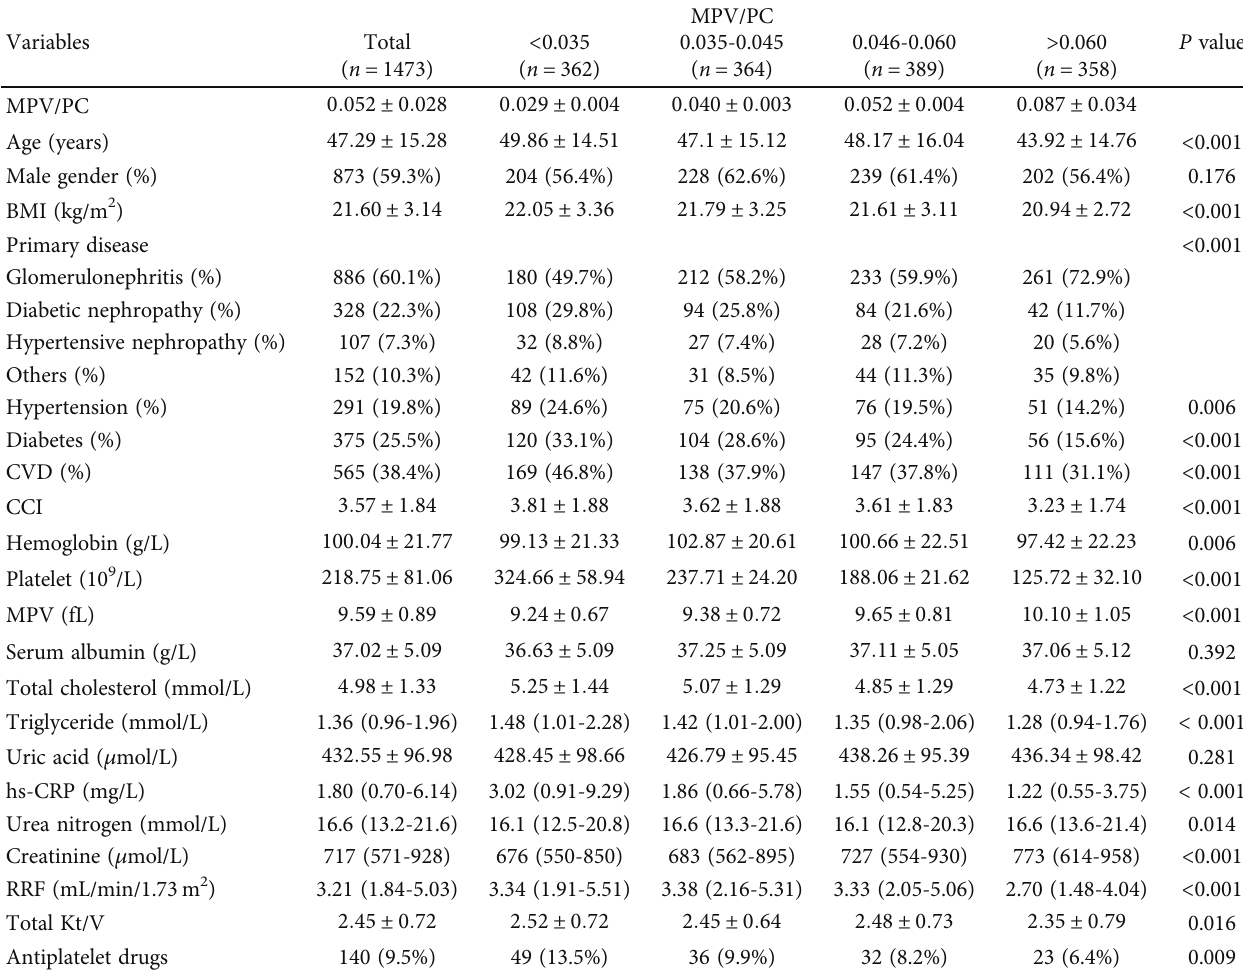
Table 1: Baseline characteristics of patients strati fi ed by MPV/PC value.